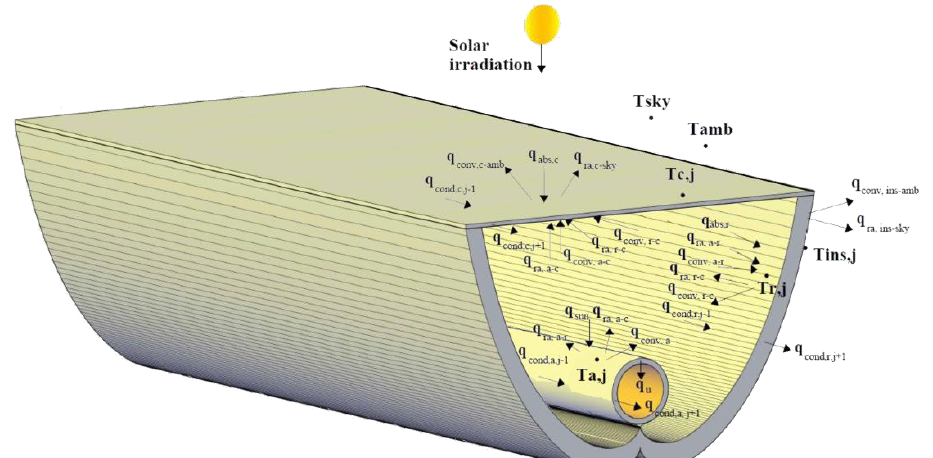
Figure 3. Heat distribution of CPC solar collectors.